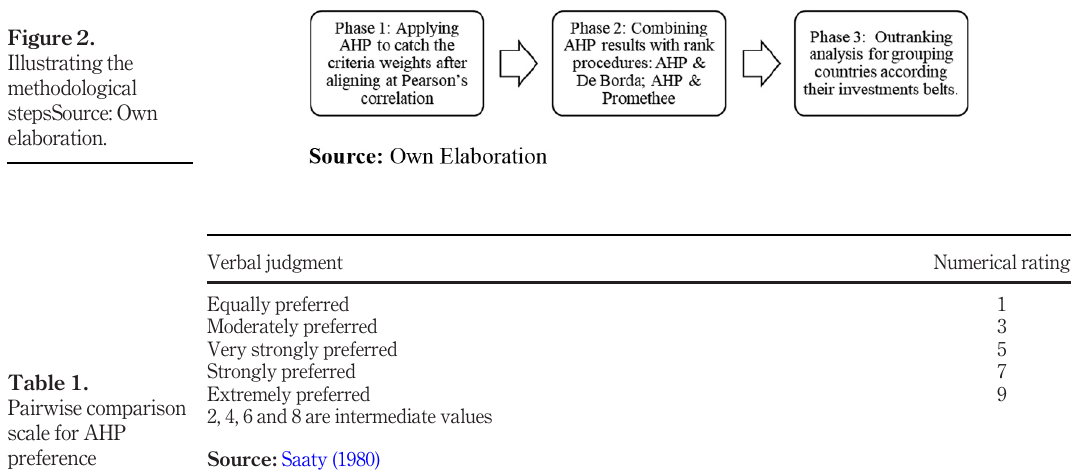
Table 1. Pairwise comparison